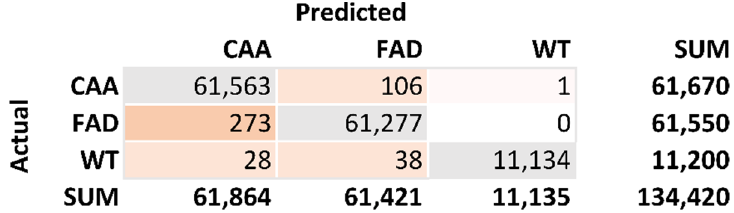
Figure 3. Confusion matrix of results. This generates this classification tree which is characterized for disease. The model trained on 66.67% of the data and tested the last 33.3%. This is used to pro- duce an accuracy of 99.67%. This was also used to calculate specificity and sensitivity of the results.